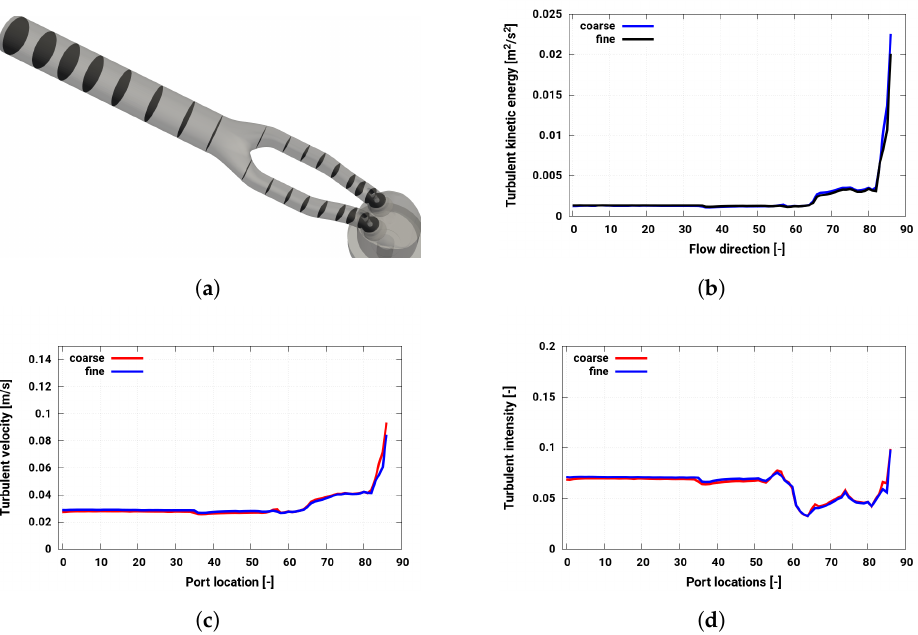
Figure 17. Evolution of turbulence properties along the intake duct: ( a ) schematic of part of the cross-sectional locations along intake duct to carry out turbulence analysis, ( b ) turbulent kinetic energy, ( c ) turbulent velocity, ( d ) turbulence